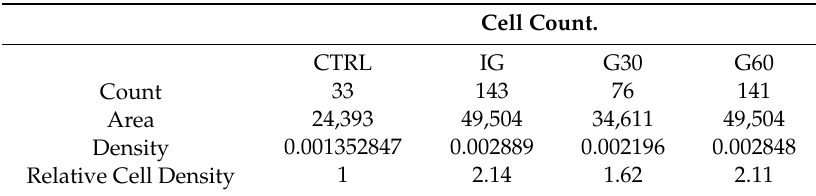
Table 3. Relative cell density as calculated on selected ROI in each sample. Cell count was normalized on cell area and then reported as relative cell density vs. control sample. Cell